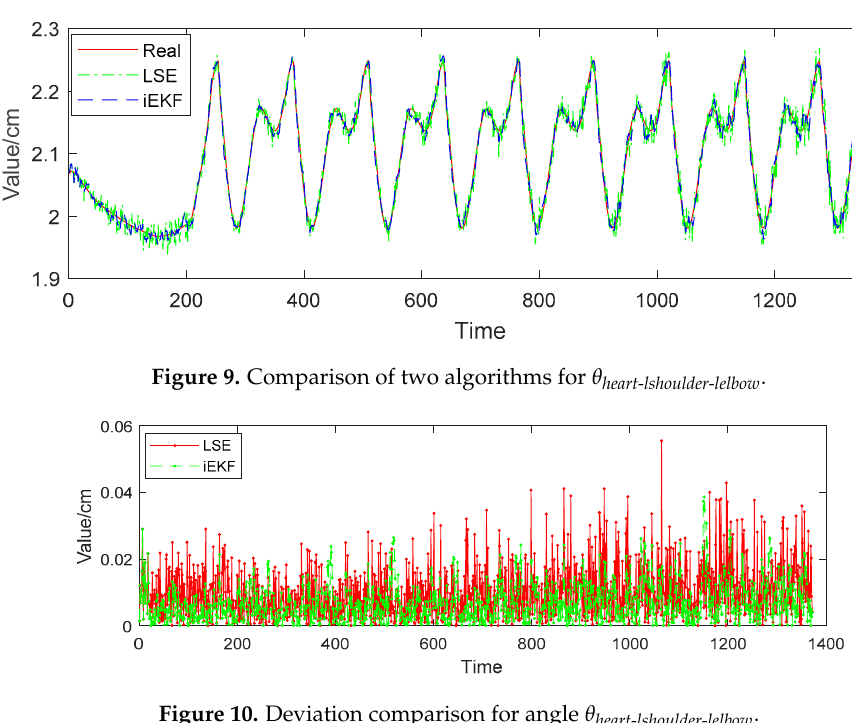
Figure 10. Deviation comparison for angle lelbow-lshoulder-heart